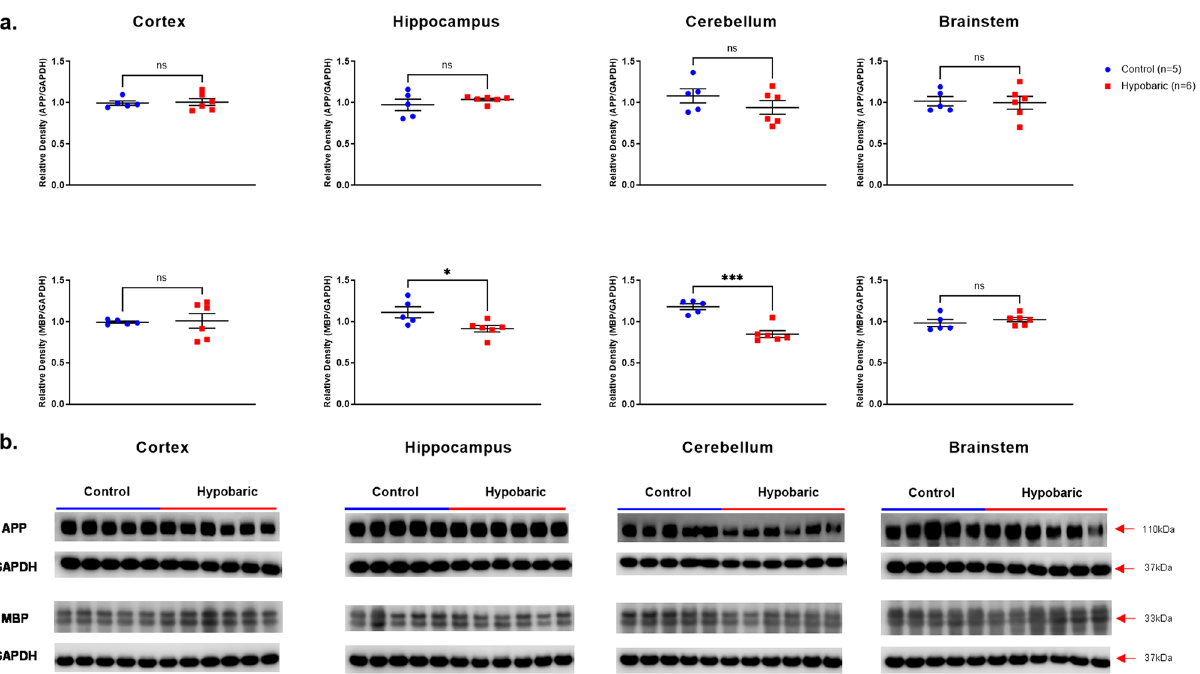
Figure 9. APP and MBP protein expression following hypobaric exposure. ( a ) Histograms representing the densitometric ratio of levels of APP and MBP with respect to GAPDH in the Control (blue spots) vs. HYPOBAR (red squares) group as measured in the frontal cortex, hippocampus, cerebellum and brainstem. All gels were run in duplicate and data represents the average of 2 runs per sample. Error bars represent standard error of the mean (SEM). * p < 0.05; ** p < 0.01 (two-tailed unpaired t -test). ( b ) Representative western blots for antibodies used. Full length blots are shown in Supplementary Figs.